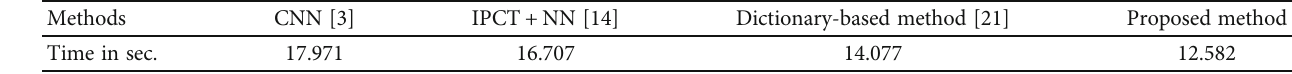
Table 2: Comparison of computational time.